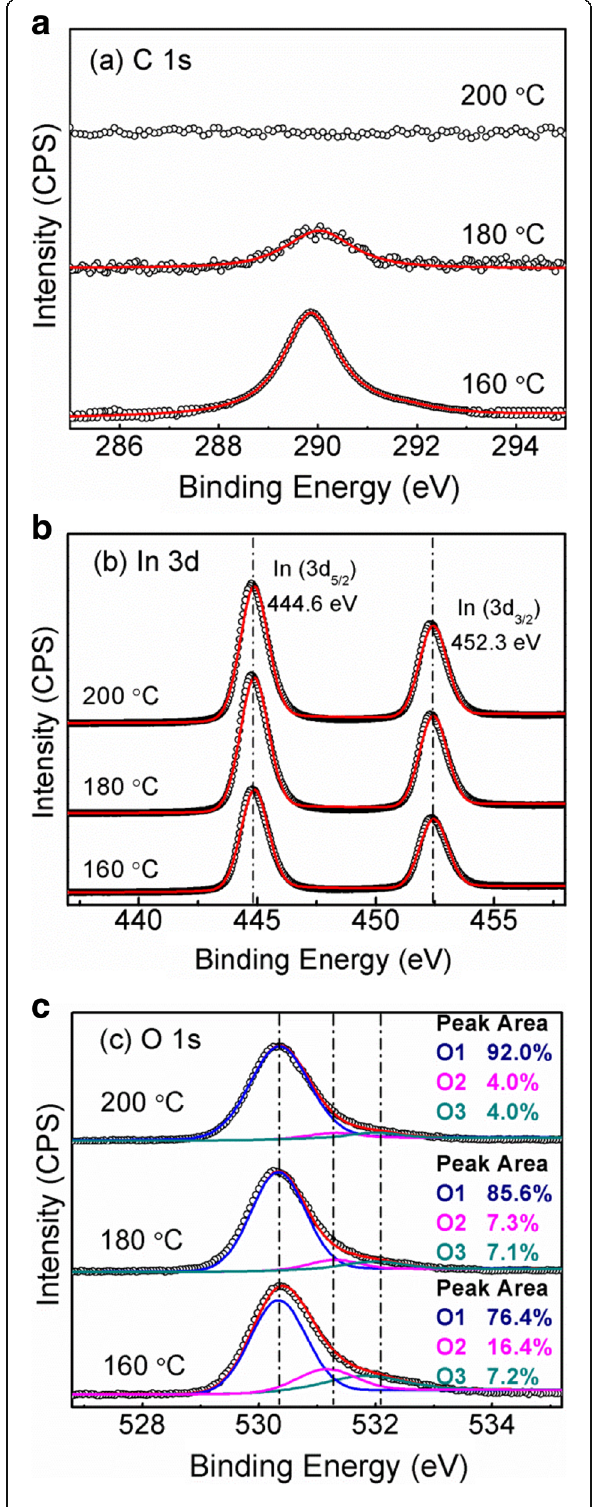
Fig. 4 High resolution a C 1s, b In 3d, and c O 1 s XPS spectra of the In 2 O 3 films deposited at 160, 180, and 200 °C, respectively. To remove adventitious surface contaminants, all the samples were etched with in-situ Ar ion bombardment for 6 min before signal collection